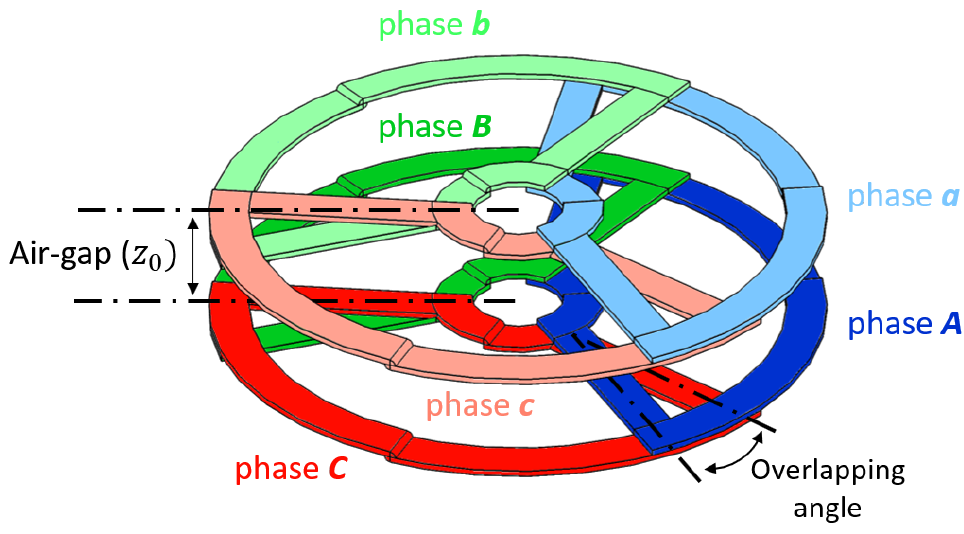
Figure 3. 3D model of the TPP electromagnetic